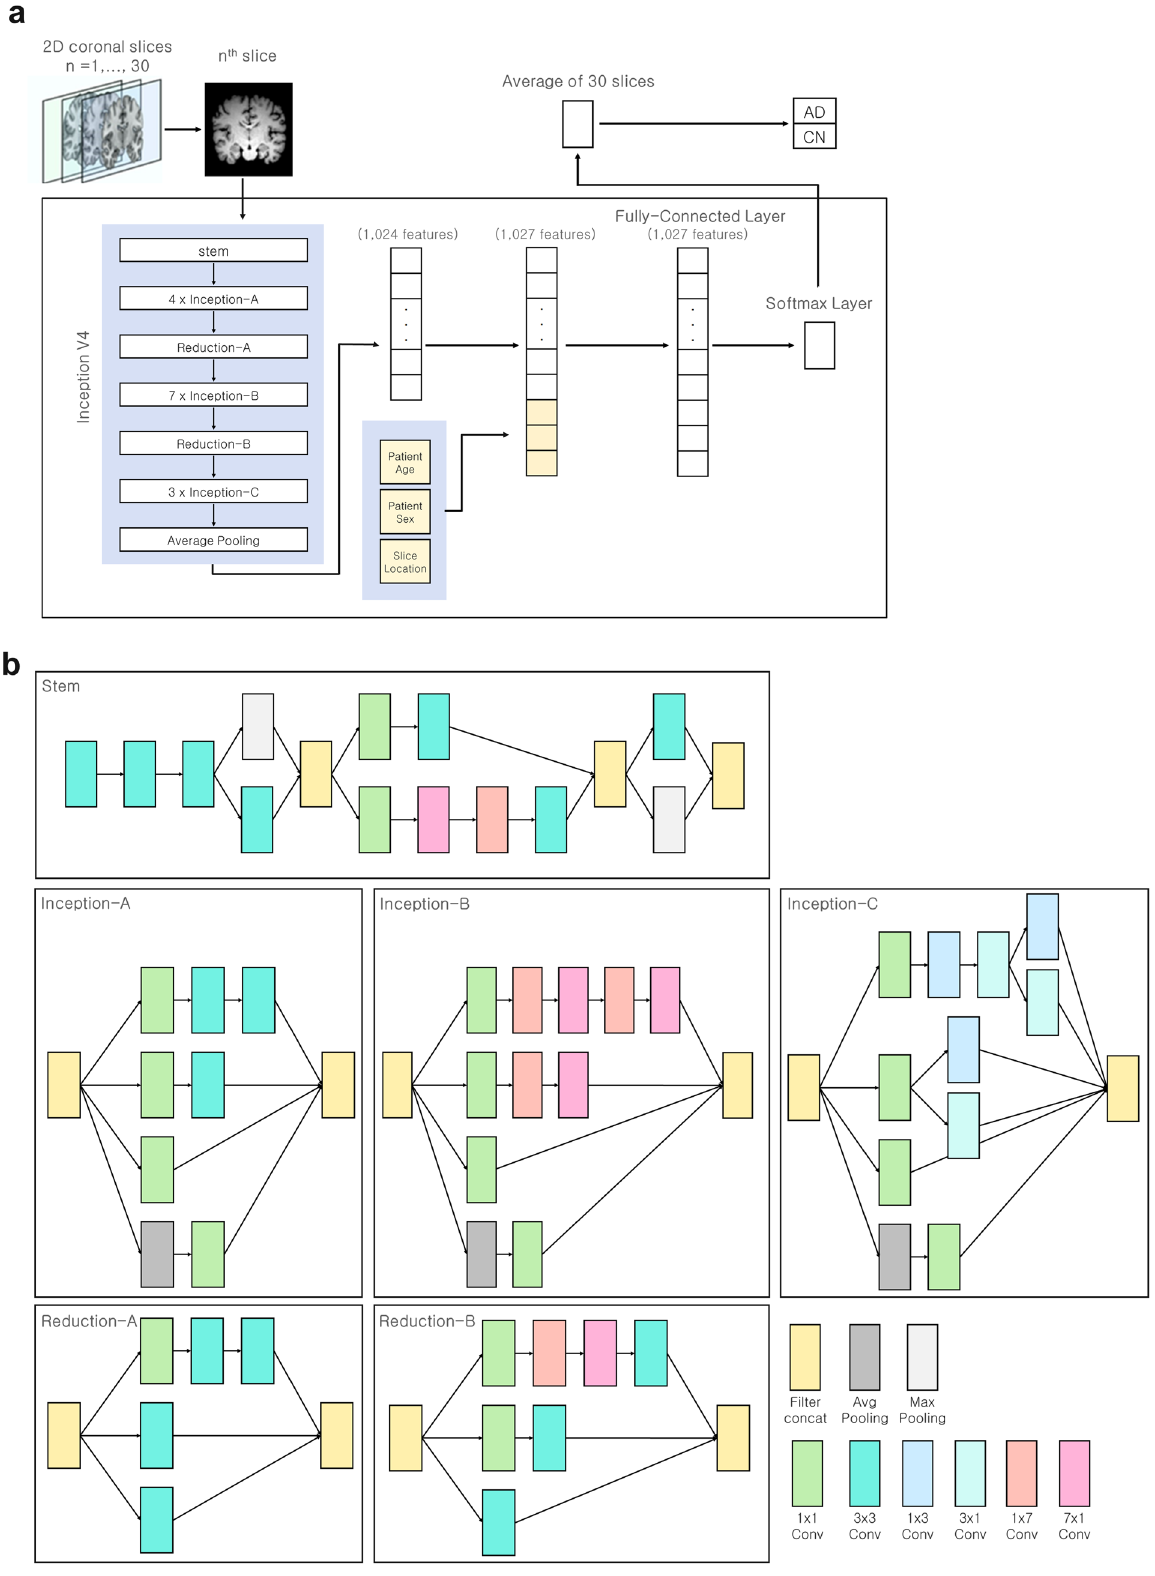
Figure 2. Diagram of the network architecture. For each subject, 1 out of 30 coronal slices are fed into the model independently, and the results of the 30 slices are averaged to produce a AD probability for that subject. The first part of the model consists of the architecture of a pretrained network (Inception V4), and the last part of the model involves the addition of the subject’s age, sex, and slice location (a) . The specific constituents of Inception v4 are shown (stem, Inception-A, Inception-B, Inception-C, Reduction-A, Reduction-B)